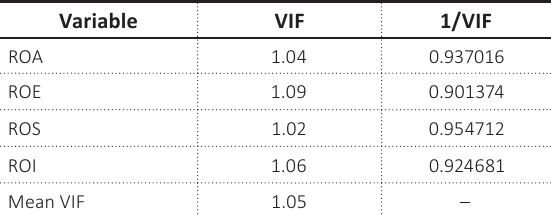
Table 4. Variance inflation factor